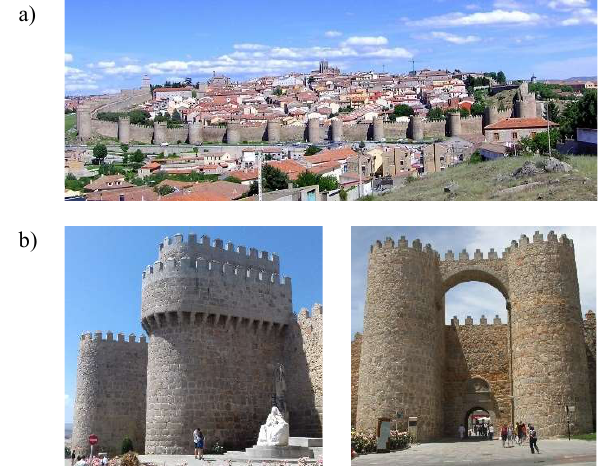
Figure 6. Medieval wall of Avila: a) general view and;